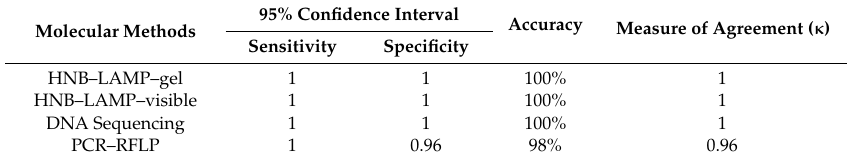
Figure 6. Accuracy and specificity of HNB–LAMP assay. ( A ) Assessment was based on the HNB color change visualization of the LAMP product. P. falciparum mutants distinguished by blue color change in reaction as shown in tubes no. 4 and 5 with the positive control DD2 indicated in tube no. 5; in disparity, the PYR wild-type strains showed a violet color reaction indicated by tubes no. 1, 2, 3, 6, 7, 8, 9, 10, 11, and 12 with wild-type control 3D7 (tube no. 2). ( B ) Assessment was based on gel electrophoresis: M-100 bp ladder, lanes 4 and 5 showed amplification (ladder-like pattern) in PYR-resistant mutants with positive control DD2 (lane 5), while no amplification was observed in wild type samples in lanes 1, 2, 3, 6, 7, 8, 9, 10, 11, and 12, including the wild-type control 3D7. Table 2. Sensitivity, specificity, and accuracy of the HNB–LAMP detection